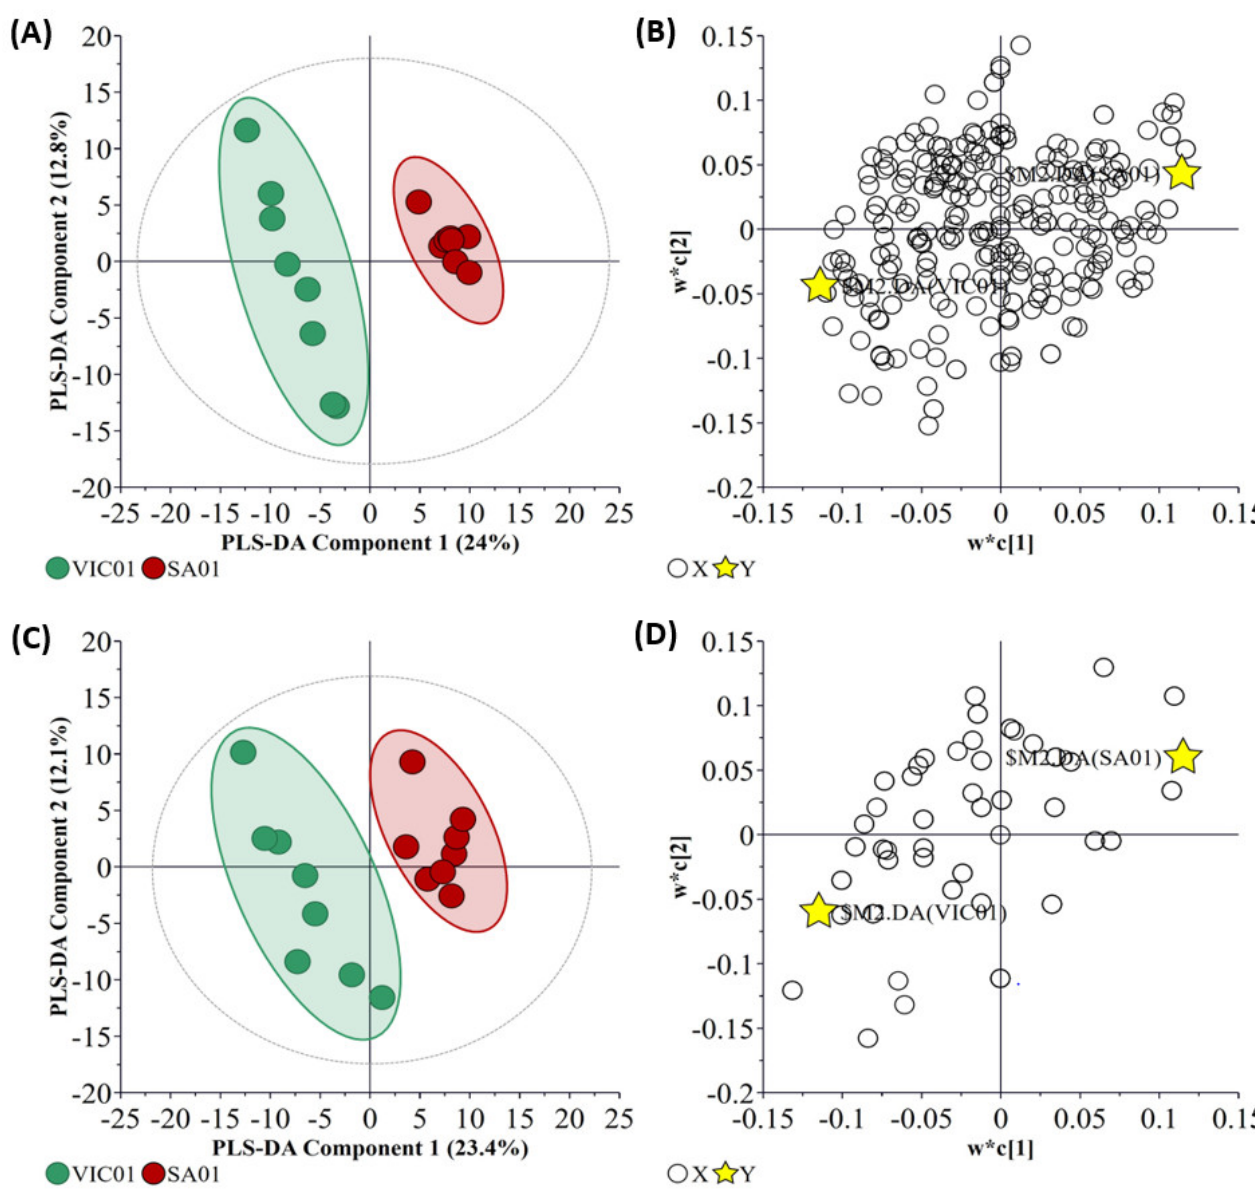
Figure 8. Overview of the LC-QToF-MS untargeted metabolite (R 2 X = 0.367, R 2 Y = 0.989, and Q 2 = 0.872, DCrit value = 1.36181) and lipid (R 2 X = 0.356, R 2 Y = 0.935, and Q 2 = 0.656, DCrit value = 1.34667) data from the two inoculated virus variants analyzed in nasal wash samples during viral shedding. ( A ) PLS-DA score scatter plot of metabolite data. ( B ) PLS-DA loading scatter plot of metabolite data. ( C ) PLS-DA score scatter plot of lipid data. ( D ) PLS-DA loading scatter plot of lipid data. The ellipse on the loadings scatter plots represents the 95% Hotelling’s threshold. Note, the ellipse presented in Figure 8A,C represents Hotelling’s T2 confidence limit (95%). Note: The colored circles in panels ( A , C ) represent each analyzed sample, while the yellow-colored stars in panels ( B , D ) indicate the average group position for each sample cluster, with the white circles representing the distribution of metabolite/lipid features between these groups.